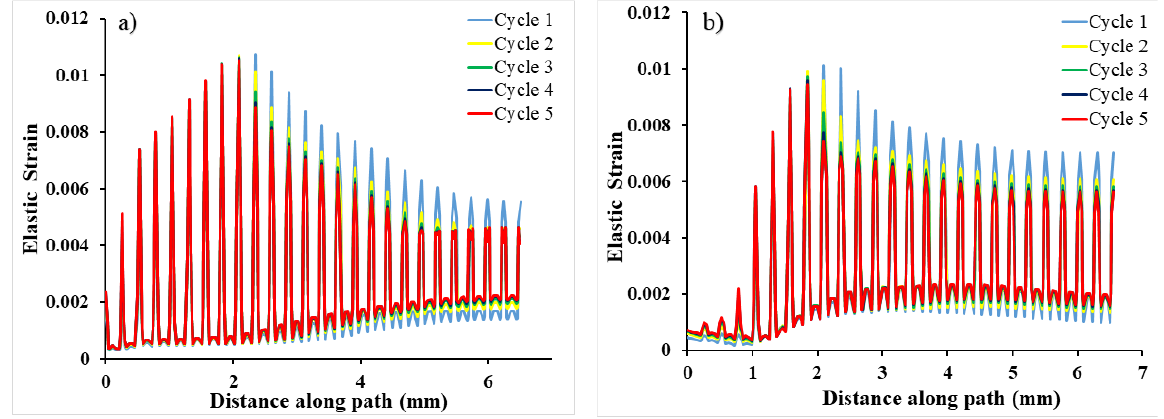
Figure 15. Elastic strain (maximum principle)–distance diagram in specific paths at the end of each cycle. ( a ) Path 1 and ( b ) Path 2.